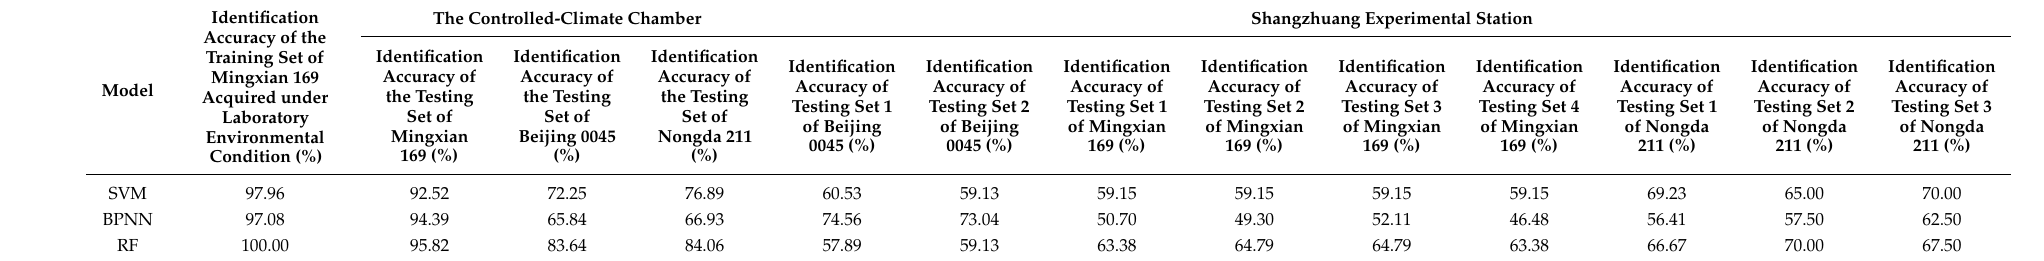
Table 15. Identification results for the individual-variety disease image testing sets acquired under laboratory environmental conditions and in the wheat field in Shangzhuang Experimental Station, and the additional testing set consisting of the multi-variety disease images acquired in the wheat field in Gangu Testing Station by using the SVM, BPNN, and RF models, built based on the training set of the variety Mingxian 169, consisting of disease images acquired under laboratory environmental